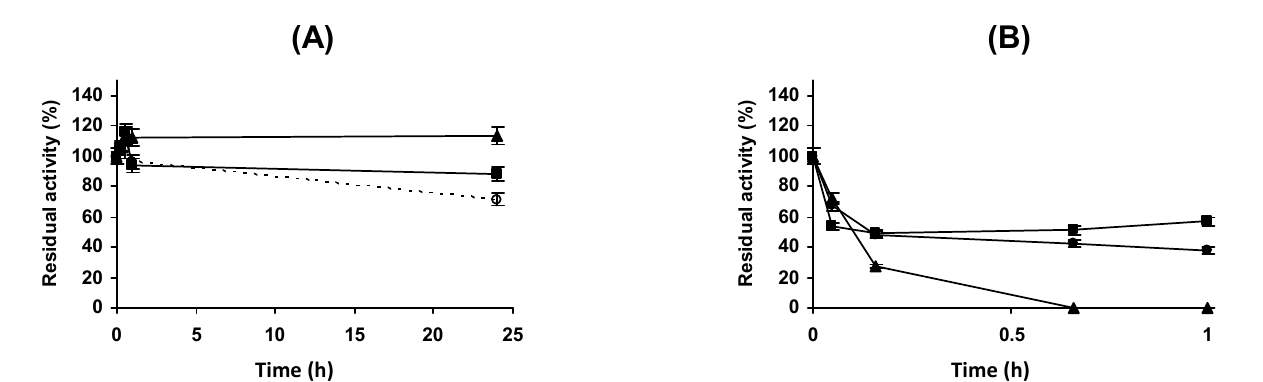
Figure 12. Effect of the incubation in presence of glutaraldehyde on the stability of different r Aae UPO preparations. ( A ) Free r Aae UPO. Full triangles: 0.1% glutaraldehyde; full squares: 1% glutaraldehyde; empty squares with dotted line: enzyme incubated without glutaraldehyde. ( B ) r Aae UPO-MANAE biocatalysts immobilized at different pH, incubated in presence of 0.1% glutaraldehyde. Full circles: MANAE biocatalyst prepared at pH 5.0; Full triangles: MANAE biocatalyst prepared at pH 7.0; Full squares: MANAE biocatalyst prepared at pH 9.0. The experiments were performed in 10 mM sodium phosphate at 25 ◦ C and pH 7.0. Other specifications can be found in the Methods section.